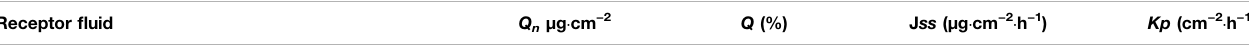
Frontiers in Nanotechnology |